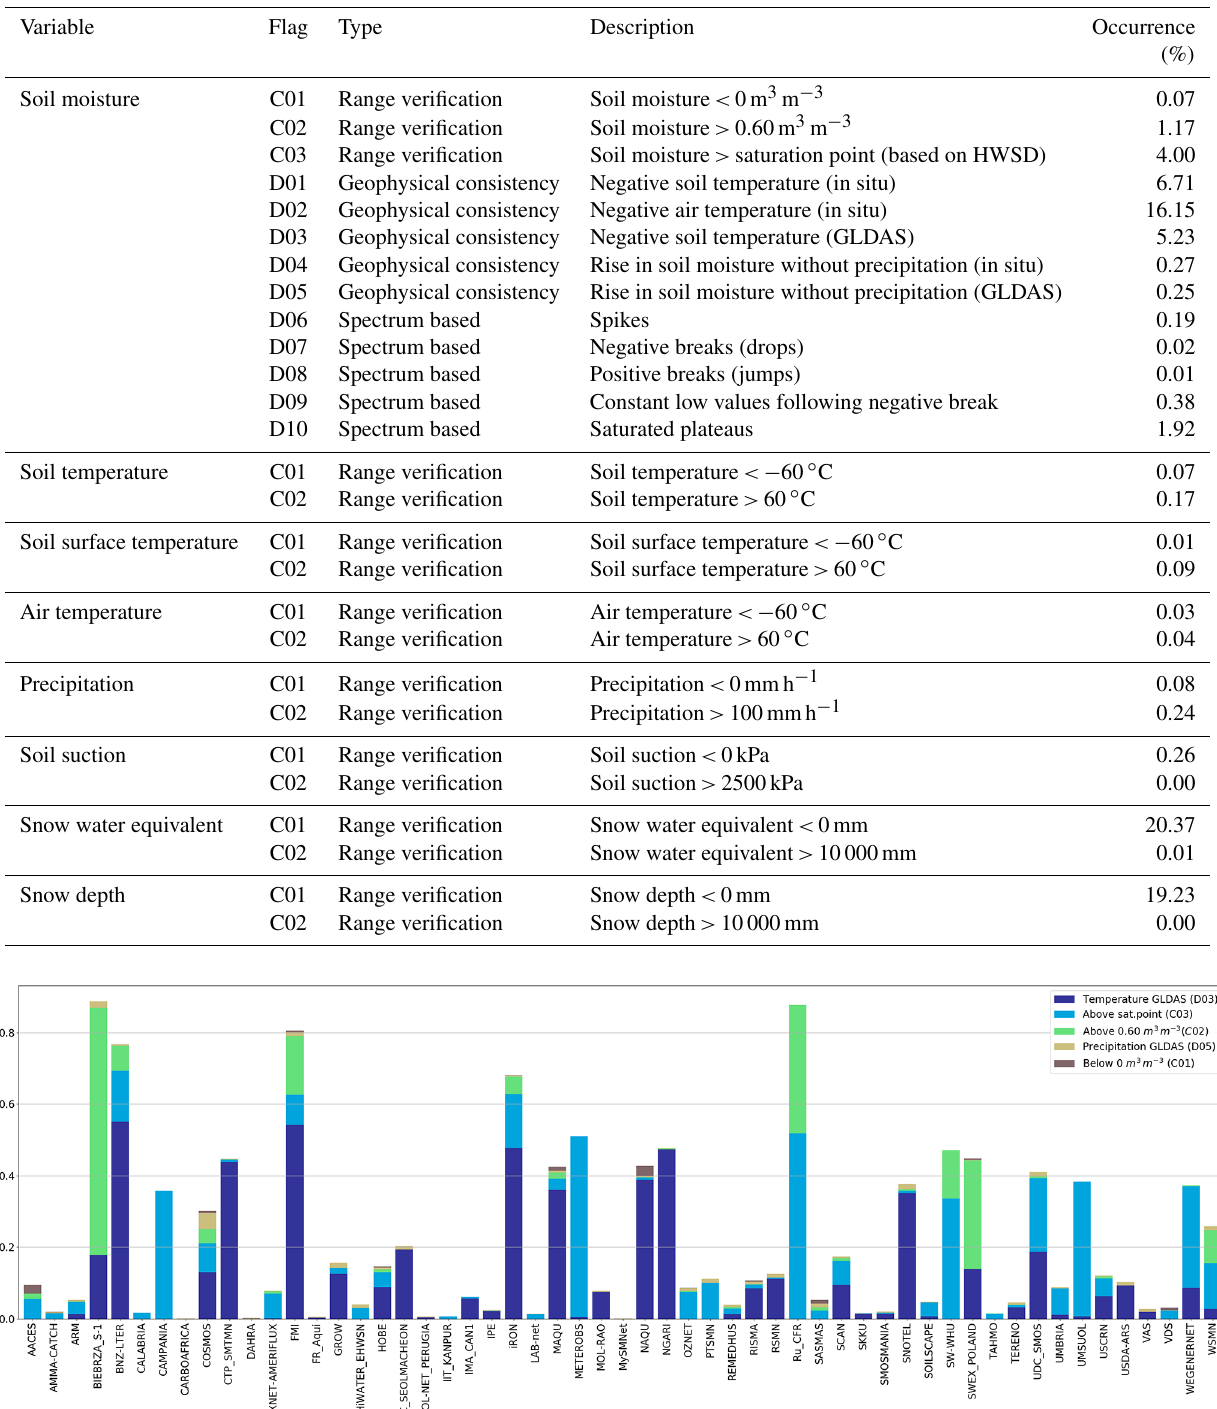
Table 3. Occurrence of flags for all variables and measurements contained in the ISMN (status in May 2021). The soil moisture flags are not exclusive, i.e. an observation can be tagged with multiple flags.